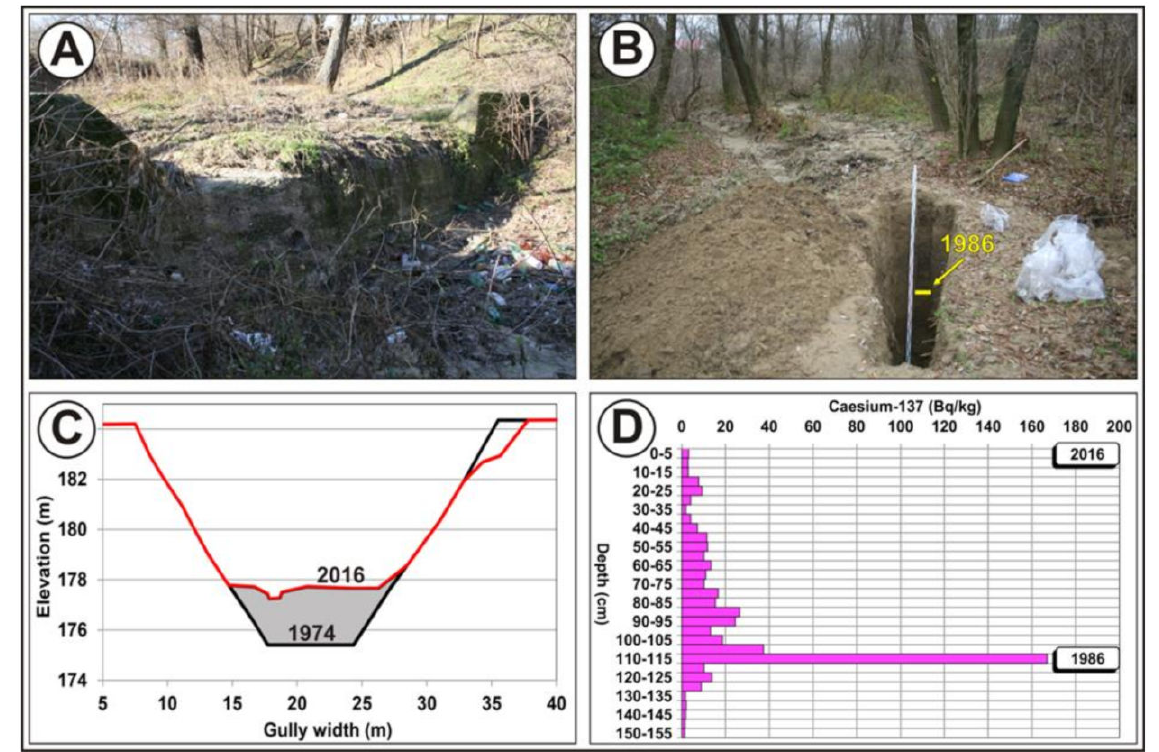
Figure 9. Gully infilling with recent alluvia after implementing conservation measures, ( A ) check dam no. 2 from the Gologofta gully on Nov. 29, 2016 (spillway bottom width = 6.6 m; vertical drop = 2.2 m from which 0.7 m is under sediments on stilling basin), ( B ) aggradation on the Balica gully floor mainly induced by afforestation on 23 November 2016, ( C ) cross section of the the Balica gully at the site of sediment profile, ( D ) depth distribution of 137Cs in the alluvia deposited on the Balica gully